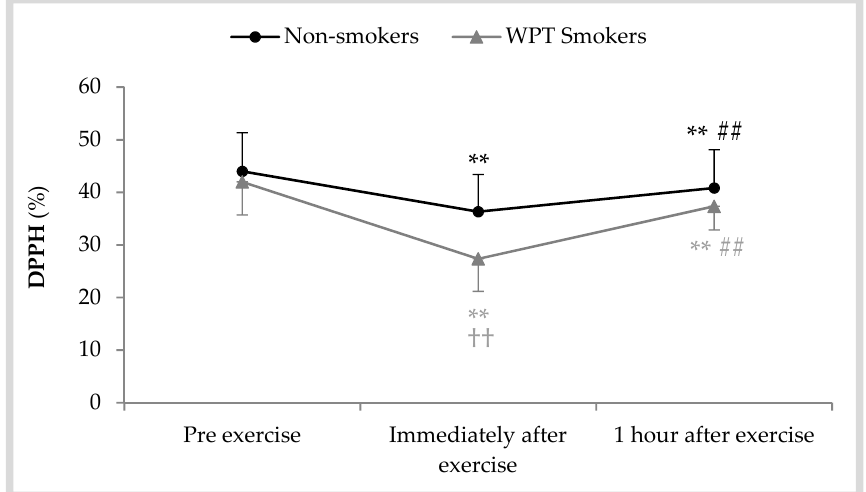
Figure 5. Salivary 2,2-diphenyl-1-picryl-hydrazyl-hydrate (DPPH) activity following a bout of exhaustive aerobic exercise in WPT smokers and non-smokers; ** p < 0.01 vs. pre, ## p < 0.01 vs. immediately after, †† p < 0.01 vs non-smokers.